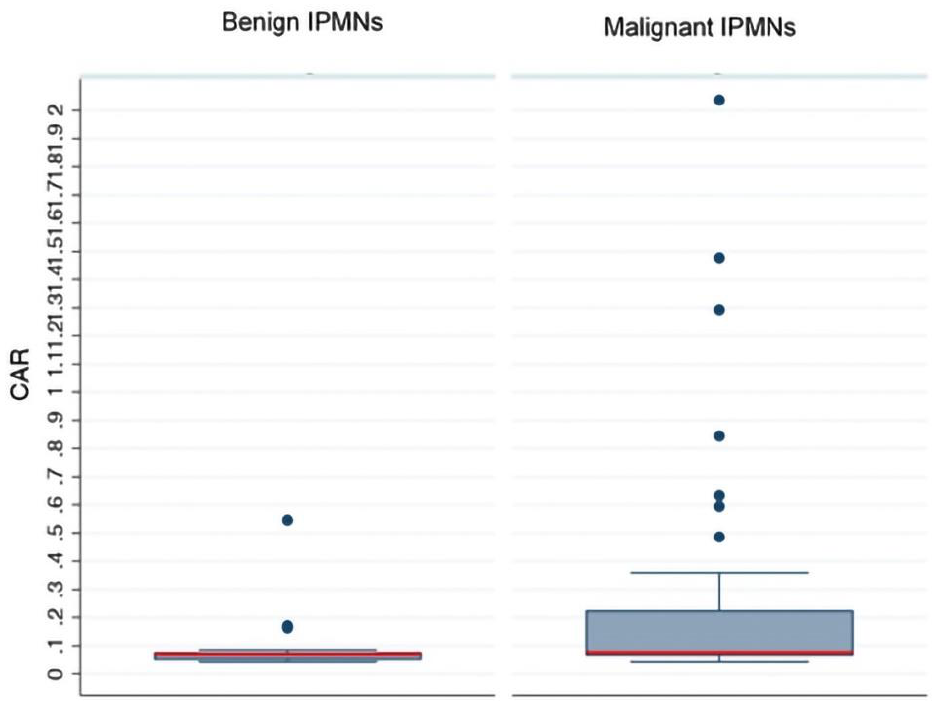
Figure 2. Quantification of CAR values in benign and malignant intraductal papillary mucinous neopla (IPMNs). The red horizontal bar represents the optimal cut off (0.083) obtained with receiver operator characteristic curves analysis and the blue ones represent the 25th and 75th percentiles. CAR: C-reactive protein to albumin ratio.